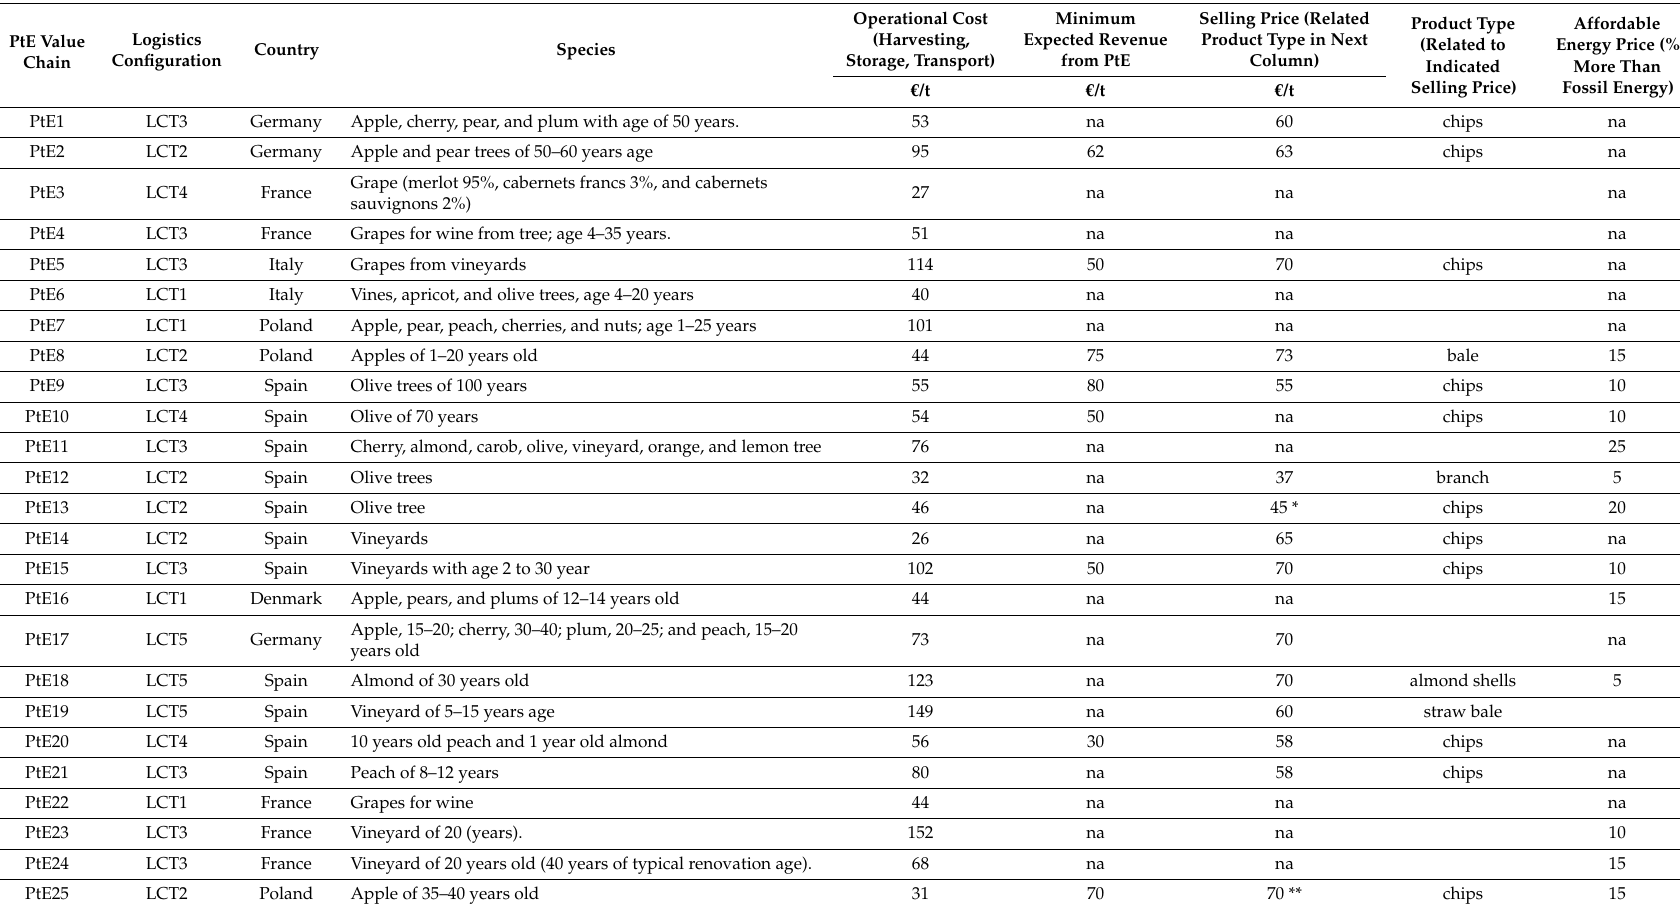
Table 5. Estimated total operational cost considering the harvesting, storage, and transport stages, in comparison with the product selling price and minimum expected